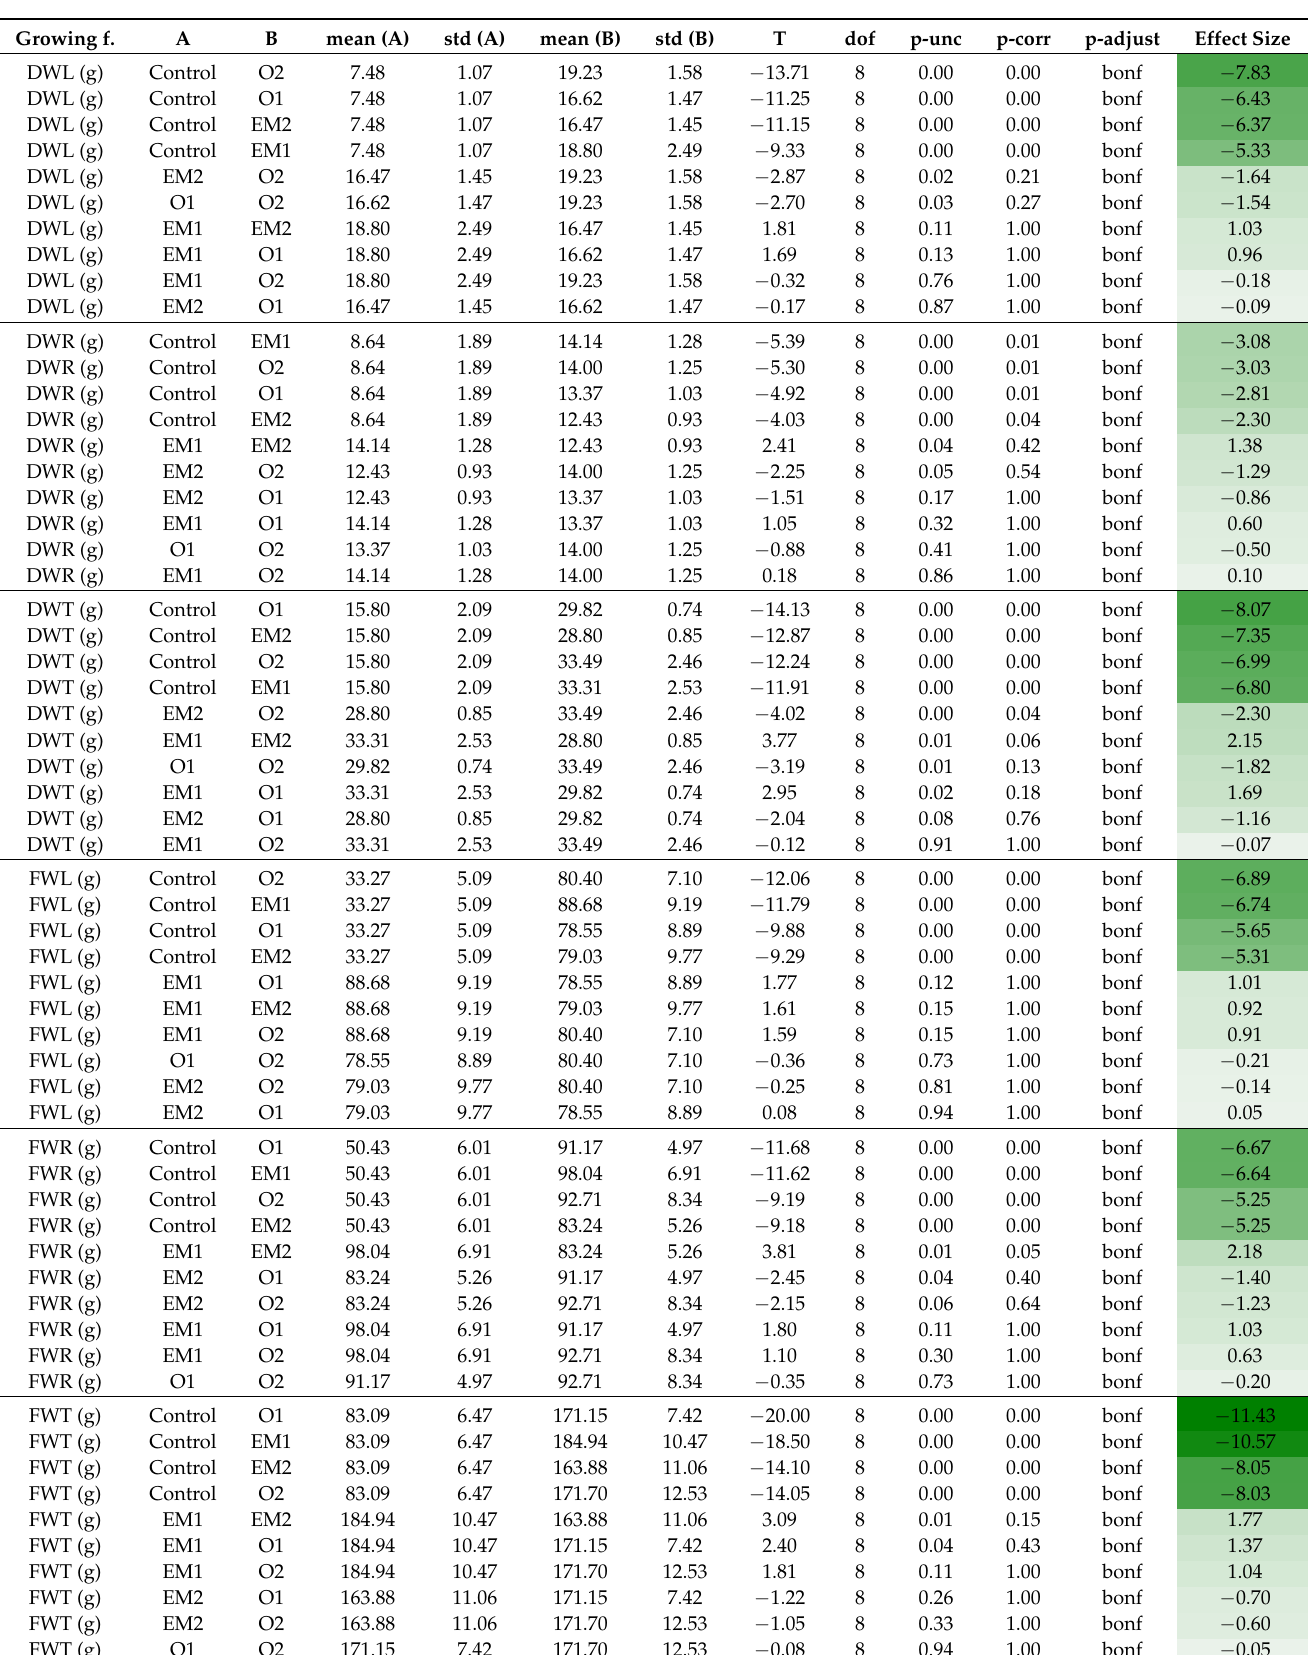
Table A2. Treatments pairwise analysis for growth